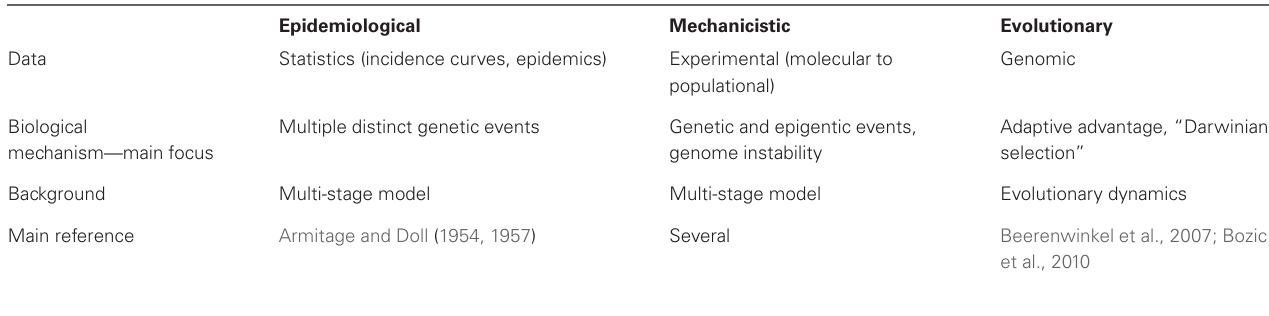
Table 1 | Theoretical models on